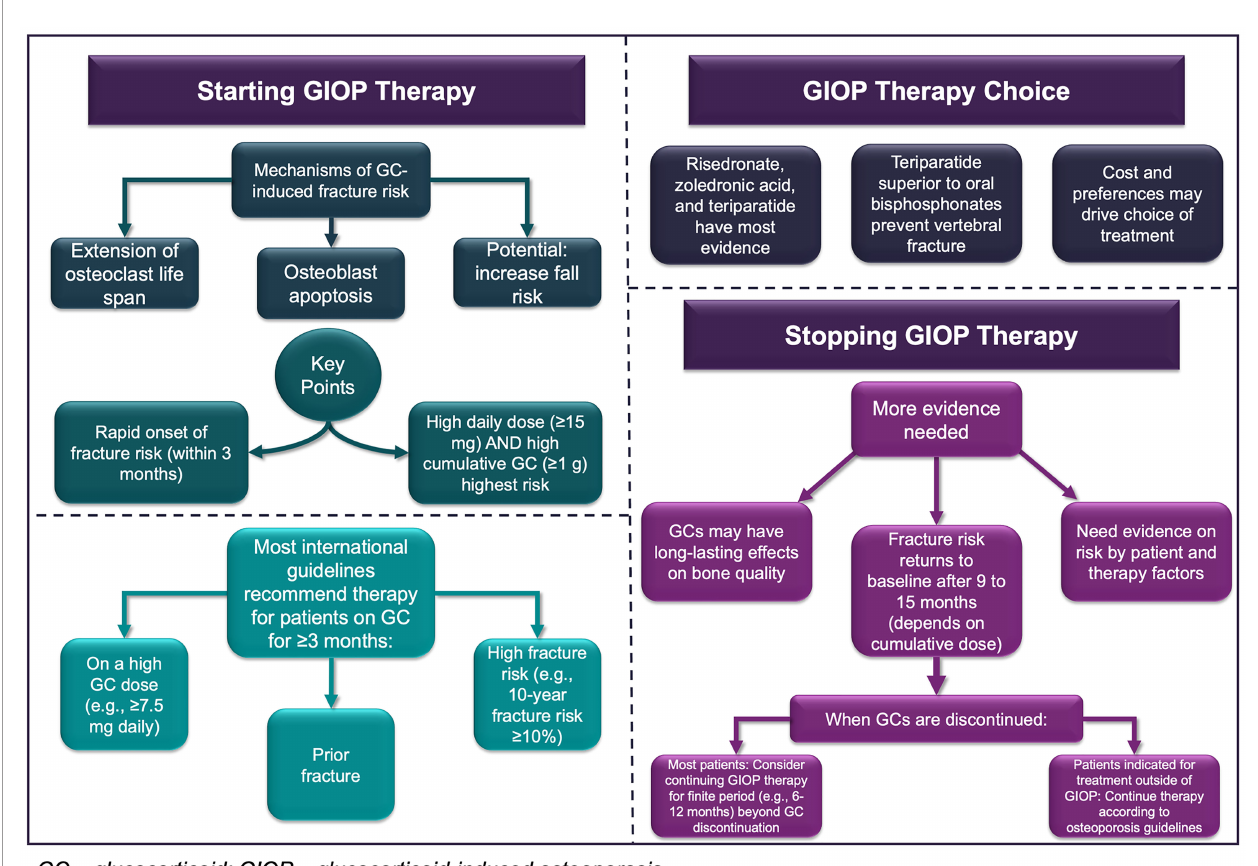
FIGURE 1 | Graphical representation of the main points presented in this